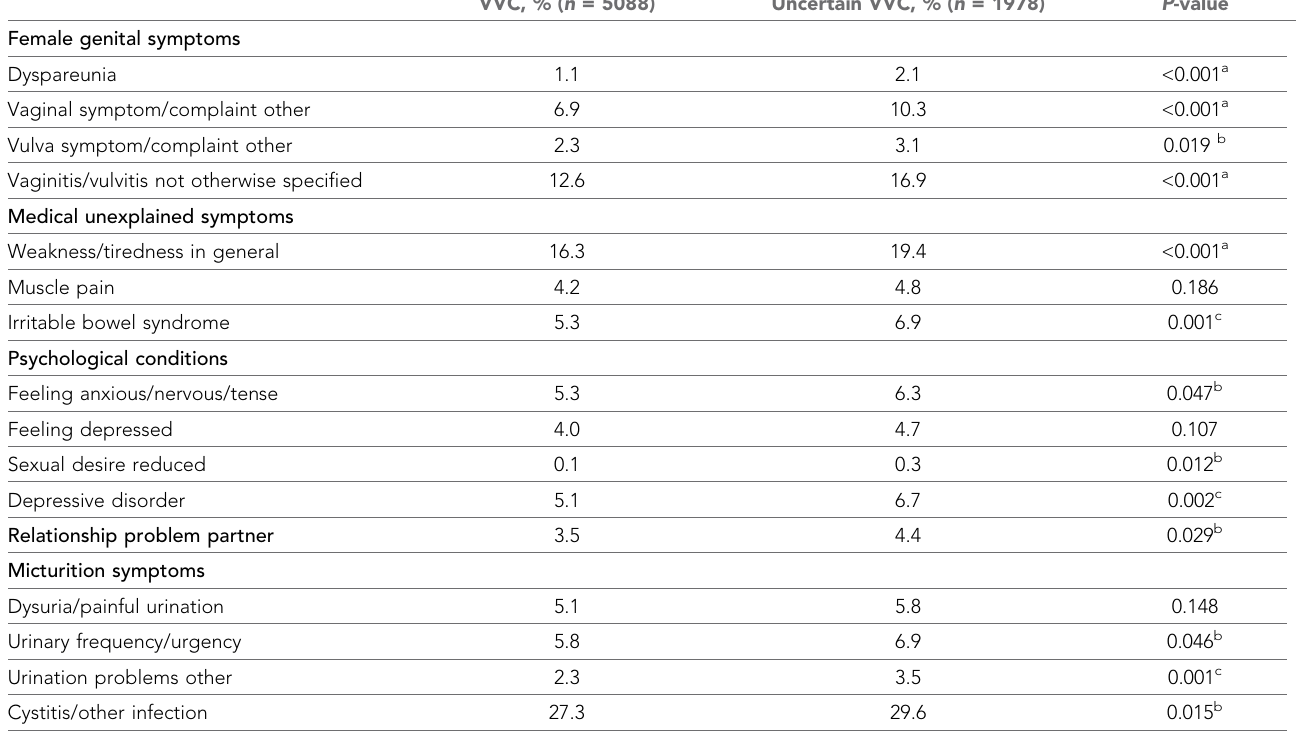
Table 1. Factors associated with provoked vulvodynia for vulvovaginal candidiasis (VVC) and uncertain VVC